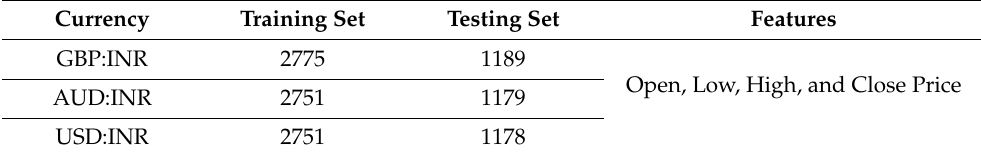
Table 3. Currency datasets experimented with for Forex market analysis. Currency Training Set Testing Set